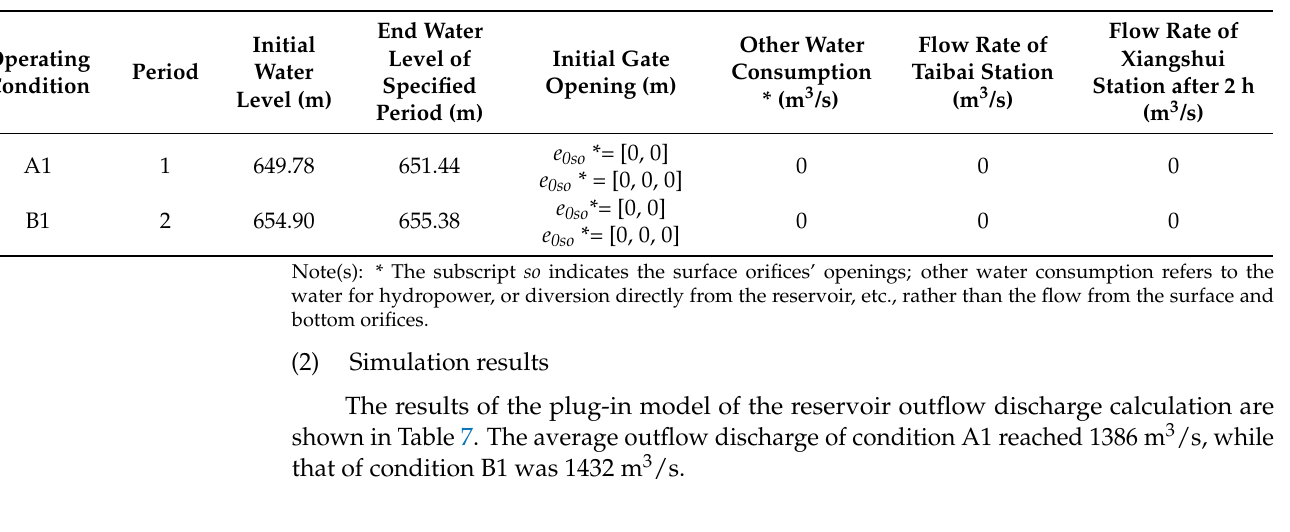
Table 6. Simulated conditions of plug-in model of reservoir outflow discharge